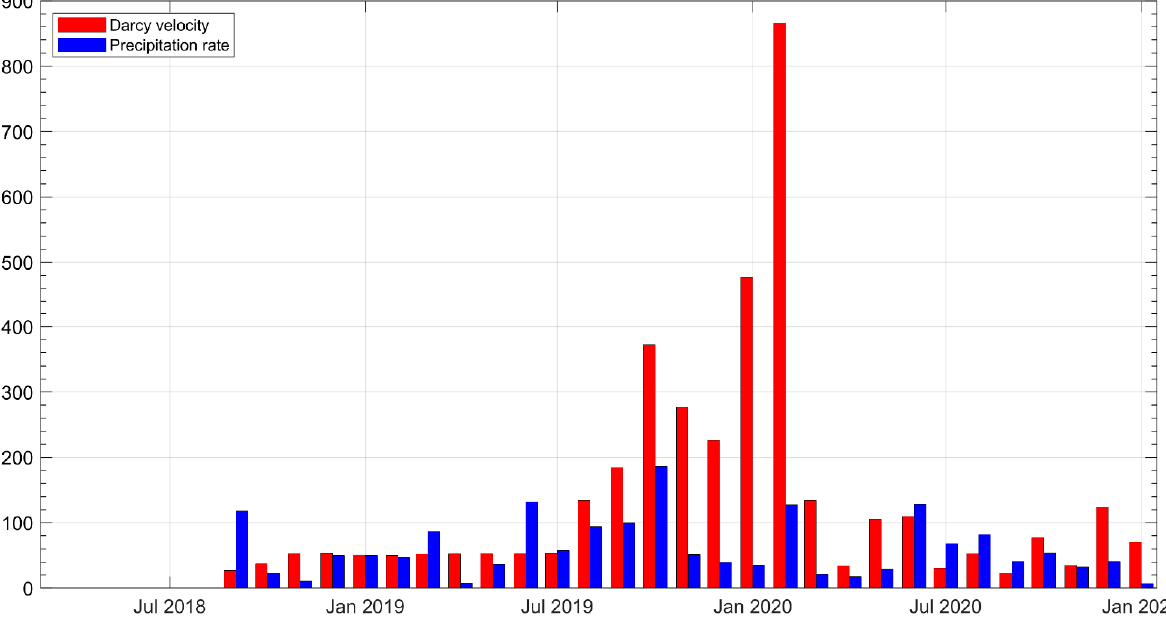
Figure 9. Monthly measured precipitation and estimated Darcy velocity from flow meter measure- ments.